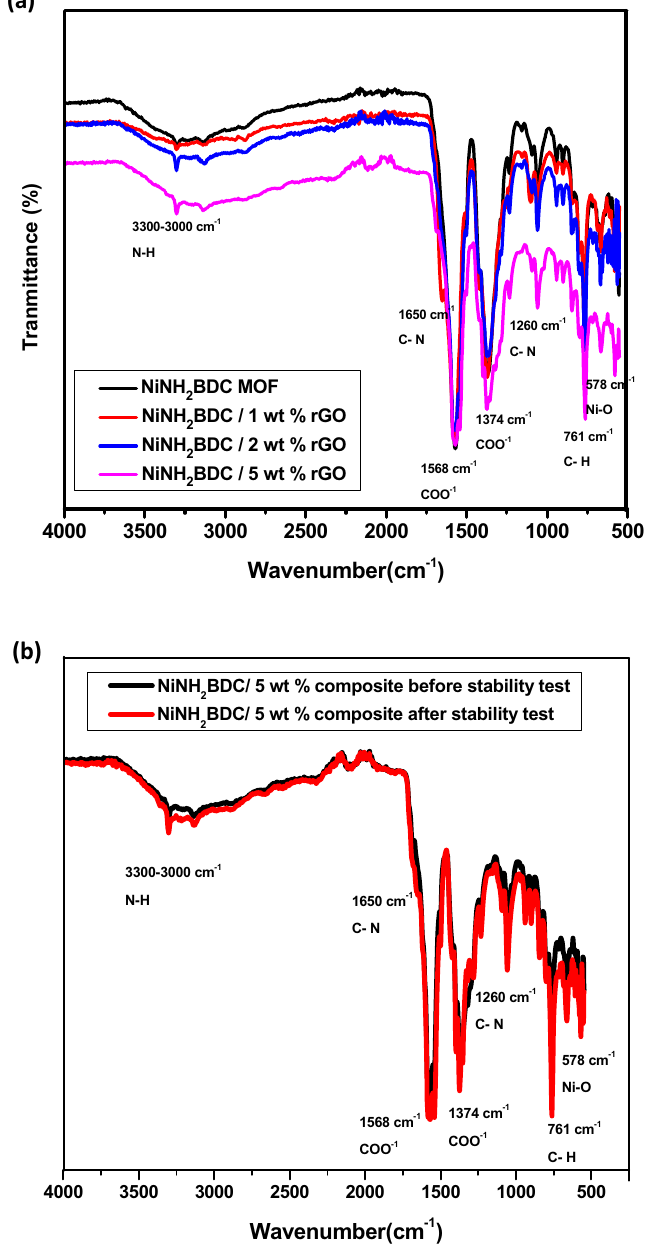
Figure 2. ( a ) Fourier transformed infrared spectrum of NiNH 2 BDC MOF/1, 2, 5 wt% reduced graphitic carbon hybrids ( b ) FTIR spectra of NiNH 2 BDC/5 wt% rGO composite before and after stability